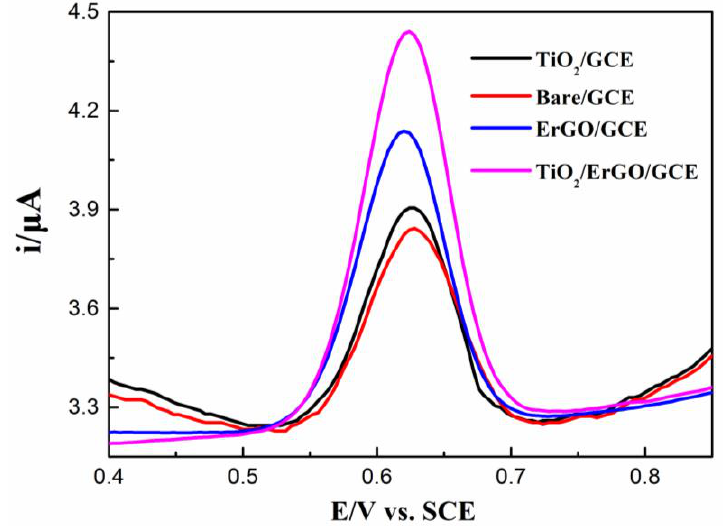
Figure 5. Differential pulse voltammetry (DPVs) of 100 μM Allura Red recorded at different modified electrodes.